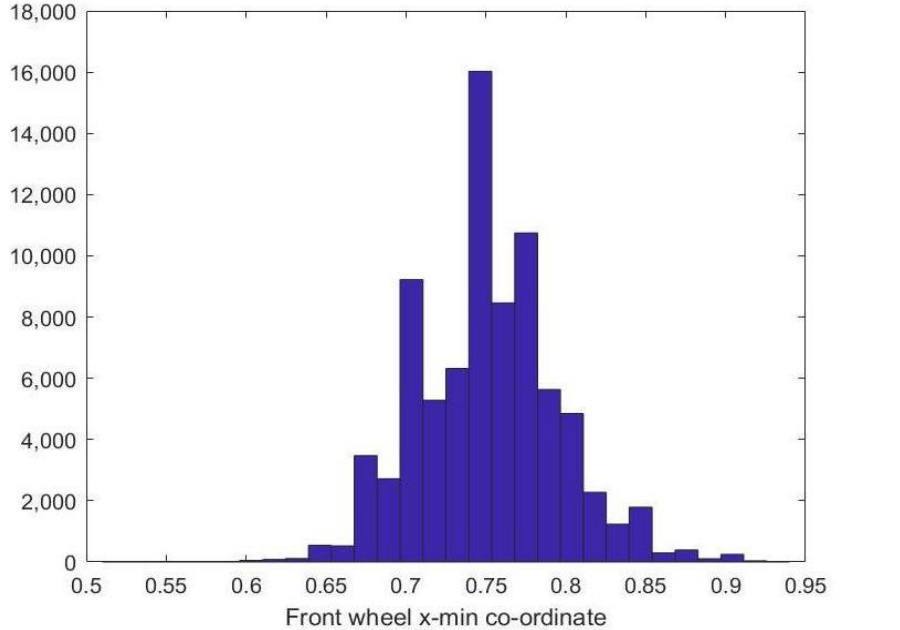
Figure 8. Front-wheel x-min co-ordinate